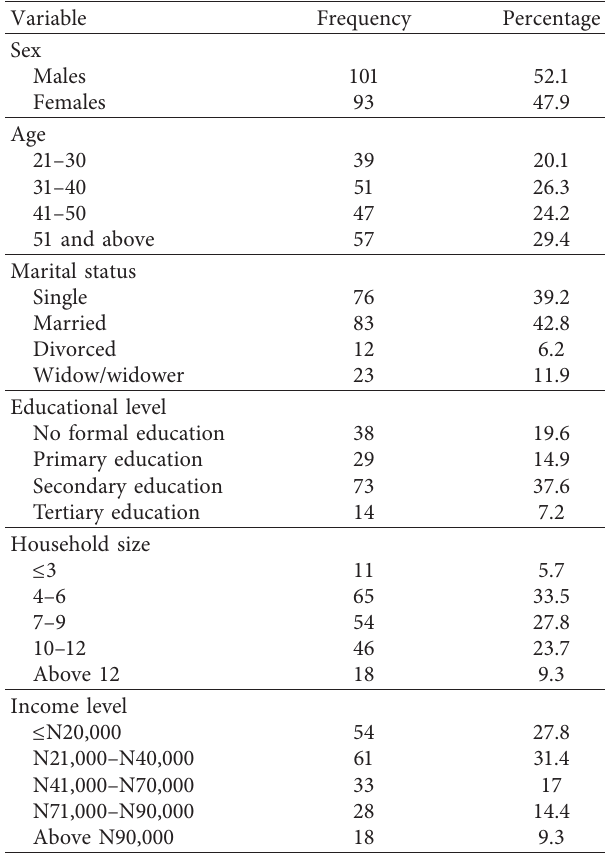
Table 1: Gender respondent’ characterization.